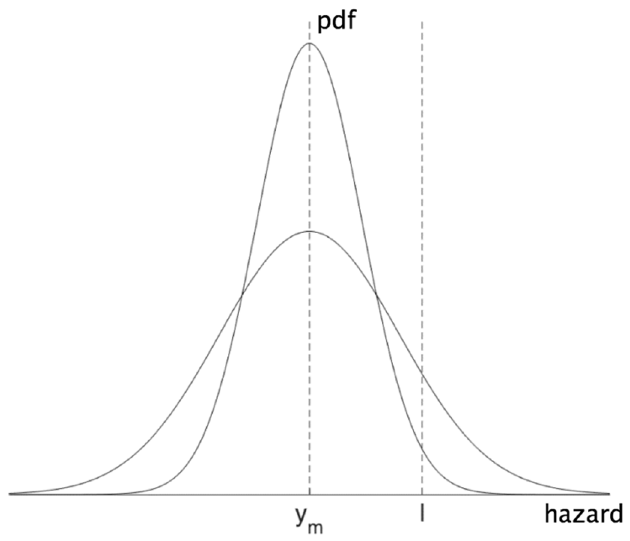
Figure 1. Representation of two constraints with the same average value and different uncertainties.